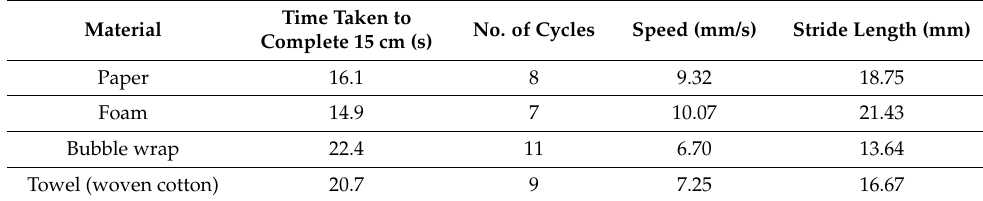
Table 4. Speed of SLEM on different frictional surfaces.